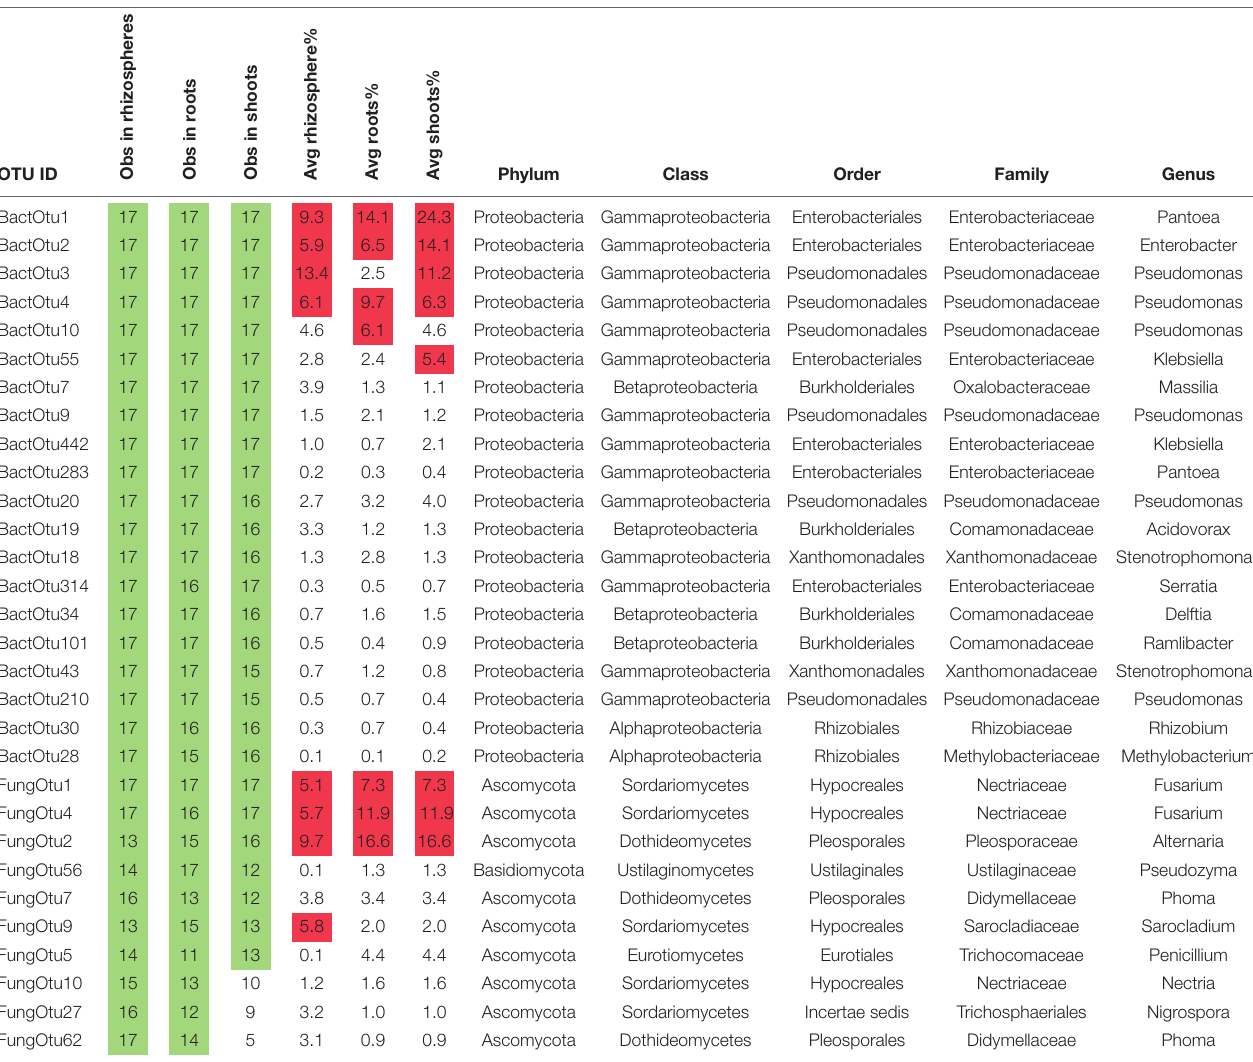
TABLE 2 | Twenty bacterial 16S and 10 fungal ITS with the highest occupancy in plants grown on soil, with common observations shaded in green and average read percentages above 5 shaded in